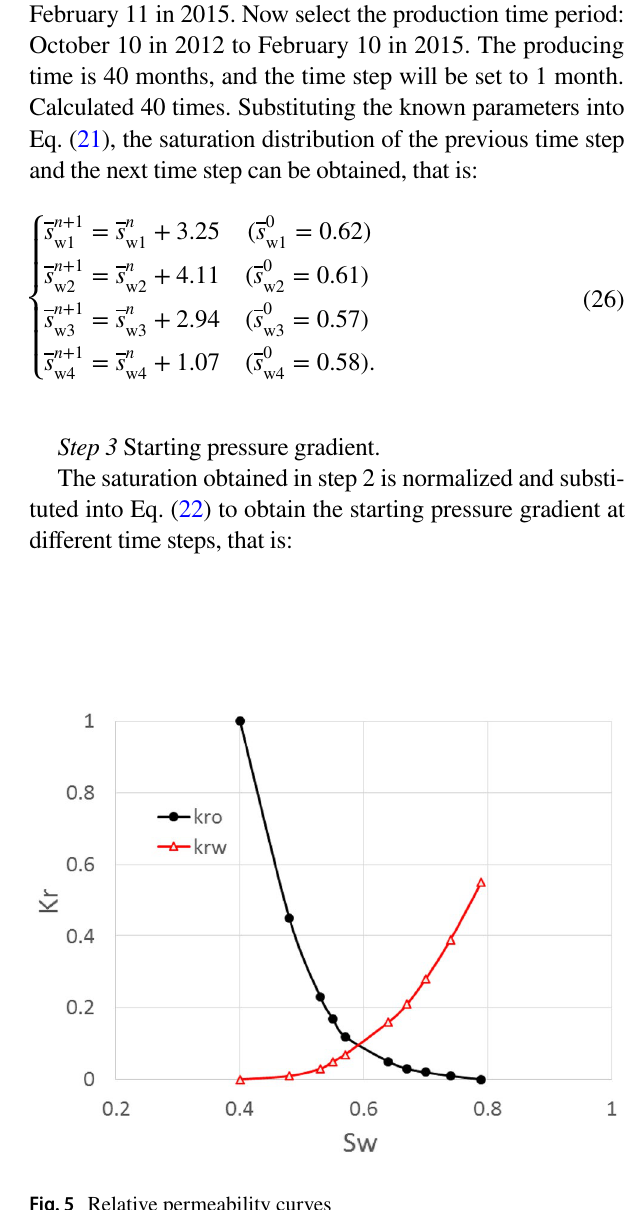
Fig. 5 Relative permeability